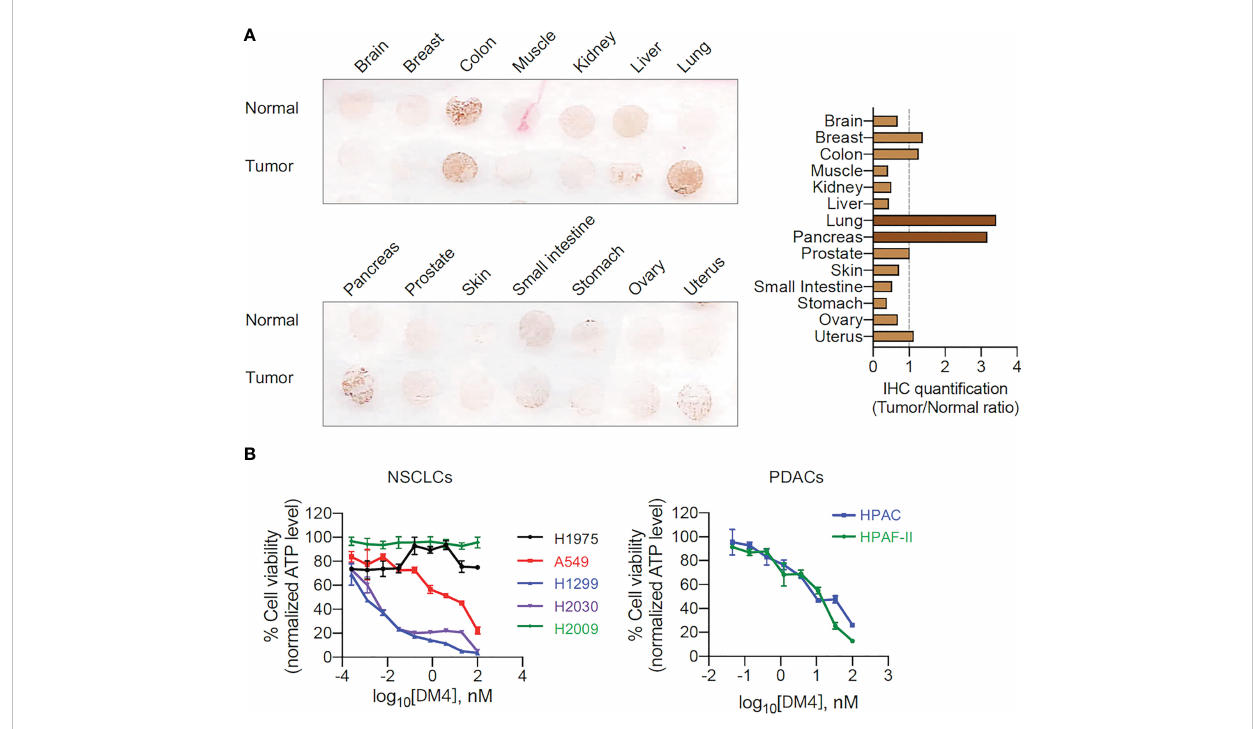
FIGURE 1 CEACAM5 expressions in different normal/tumor tissues and DM4 sensitivity in NSCLCs and PDACs. (A) CEACAM5 immunohistochemistry (IHC) of 14 tumor tissues and 14 correspondent normal tissues in tissue microarray (left panel) and quanti fi cation values of IHC images (right panel). (B) DM4 response curves in NSCLCs (H1975, A549, H1299, H2030, and H2009 cells) and PDACs (HPAC and HPAF-II cells). Normalized % cell viability (ATP level) was calculated by normalizing luminescence values using buffer (DMSO)-treated respective cells. Results are shown as the mean ±SD for representative data from three independent